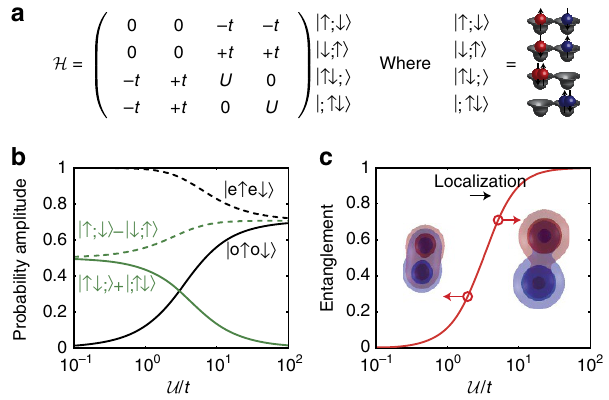
Figure 2 | Hubbard interactions and entanglement entropy. ( a ) Two-site Hubbard Hamiltonian in the subspace of the ground state, with tunnel coupling t hybridizing singly- and doubly-occupied configurations, for sites A (red orbital) and B (blue orbital). ( b ) Dependence of probability amplitudes on interactions U = t : g c (green dashed) and g i (green solid) for configurations " ; #j i(cid:2) # ; "j ið Þ and "# ; j increasing Hubbard interactions U = t . This occurs because of localization of red and blue orbitals associated with spins in the singlet, as illustrated in the